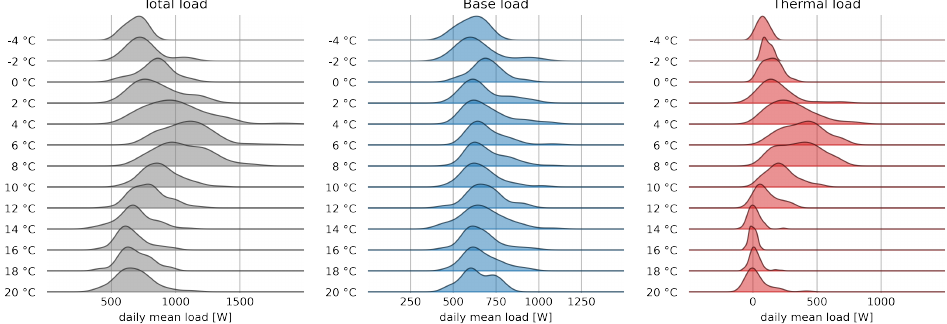
Figure 1. Ridgeline plot of average daily total, base, and thermal load distribution as a function of mean outdoor temperature.